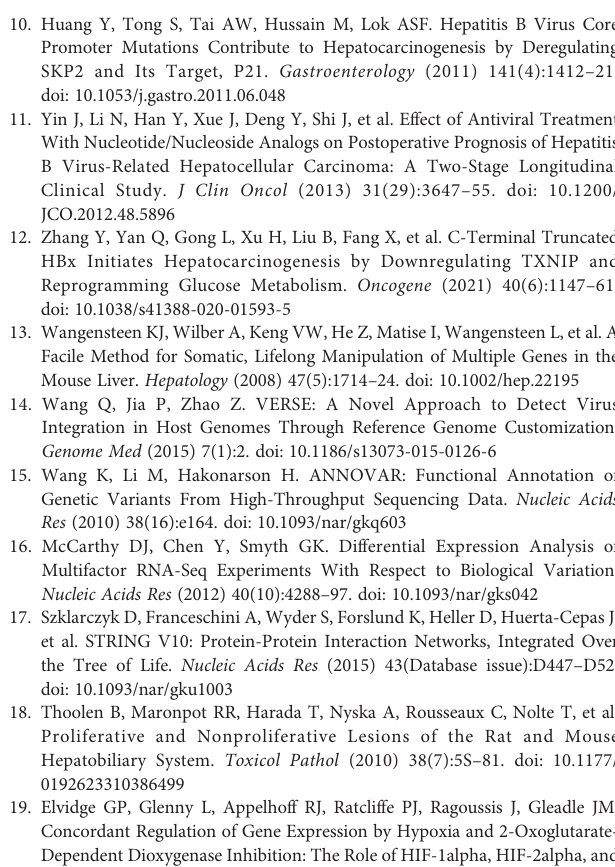
HBx fragment carrying combo mutation A1762T/G1764A+T1674G+T1753C; M3, the HBx fragment carrying combo mutation C1653T+T1674G+A1762T/G1764A; Ct, the fragment of carboxylic acid-terminal truncated HBx. Supplementary Figure 3 | The serum levels and the positive rates of cytokines in the SB mouse models. (A) The serum level of VEGF. (B) The serum level of TGF b . (C) The positive rate of IFN a . (D) The positive rate of GM-CSF. (E) The serum levels of VEGF and TGF b in the mouse models with or without tumor. (F) The positive rates of IFN a and GM-CSF. N, the tumor-free mice; T, the mice with tumor. Supplementary Figure 4 | Effects of HBx mutations on malignant phenotypes of cancer cells. (A) The overexpression of WT-HBx and HBx mutants in HepG2 and HeLa cells. (B) Ectopic expression of the HBx mutants had no signi fi cant effect on the invasion of HepG2 and HeLa cells, compared to WT-HBx. (C) Representative images of the transwell assays for cell migration in HepG2 cells. (D) Representative images of the transwell assays for cell invasion in HepG2 cells. Supplementary Figure 5 | Protein-protein interaction (PPI) networks and in fl ammatory gene set identi fi ed in cDNA microarray data. (A) PPI networks generatedwiththedifferentialgenesidenti fi edinM3-HBxexpressingHeLacellsand Ct-HBx expressing HeLa cells. (B) CROONQUIST_IL6_DEPRIVATION_DN, the IL- 6-related gene set, was signi fi cantly enriched in the cDNA microarray data of M3- HBx-injected mice. (C) CROONQUIST_IL6_DEPRIVATION_DN, the IL-6-related gene set, was signi fi cantly enriched in the cDNA microarray data of Ct-HBx-injected mice. Supplementary Figure 6 | The effects of HBx mutants on the promoter activities of PAI1 , CDC20 , and P21. (A) The results of luciferase assays in HepG2 cells. (B) The results of luciferase assays in HeLa